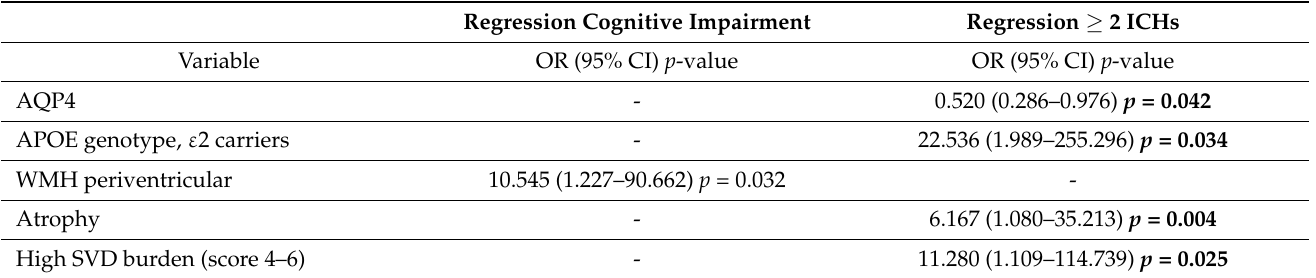
Figure 1. Association between AQP4 levels and hemorrhagic events in the CAA–ICH cohort. ( A ) Box- plot distribution according to the number of symptomatic ICHs (1 ICH, n = 43; ≥ 2 ICH, n = 17). ( B ) Boxplot distribution according to the number of lobar CMBs (<5 CMB, n = 34; ≥ 5 CMB, n = 26). ICH, intracerebral hemorrhage; CMB, cerebral microbleed. Table 5. Binary logistic regression for cognitive impairment and ≥ 2 ICHs.